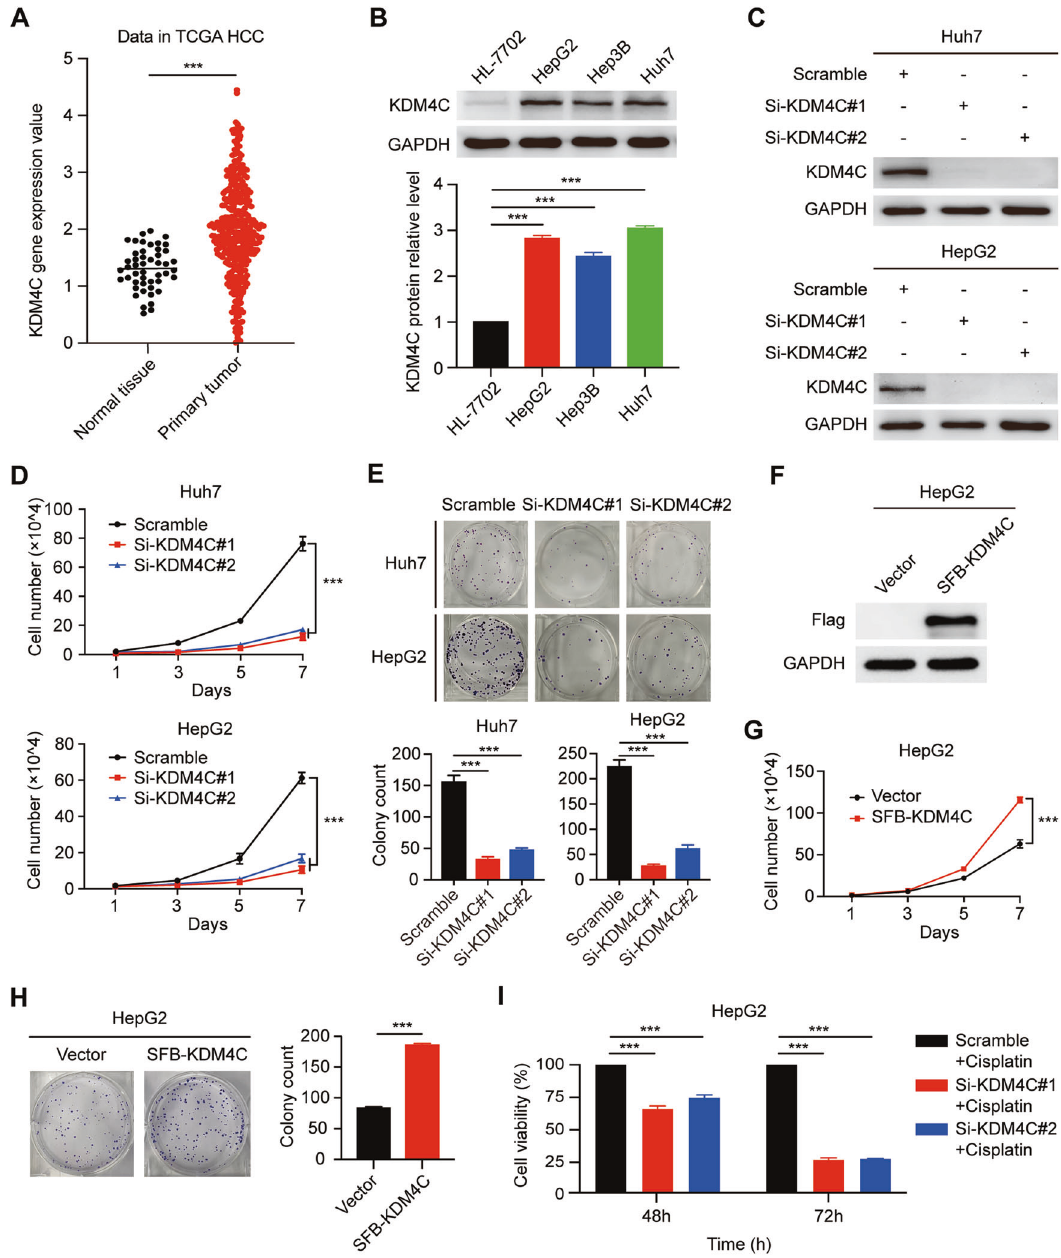
Fig. 1 KDM4C is upregulated in HCC and promotes cell growth and proliferation. A KDM4C was upregulated in primary HCC tumor tissue than in normal tissue in TCGA dataset. B Upper panel: the protein expression levels of KDM4C in several cell lines were measured by western blotting. Lower panel: the gray values of the protein bands were quanti fi ed using ImageJ software ( n = 3). C KDM4C was effectively knocked down in Huh7 and HepG2 cells using the two indicated siRNAs ( n = 3). D Cells were transfected with the indicated siRNAs, seeded in six-well plates and counted every other day ( n = 3). E Cells transfected with the indicated siRNAs were plated and cultured in six-well plates (500 cells/ well) for 2 weeks followed by fi xation and staining. Colony (>50 cells) numbers were counted ( n = 3). F HepG2 cells transfected with SFB- tagged KDM4C were lysed and analyzed by western blotting ( n = 3). G , H Overexpression of KDM4C promoted cell growth and proliferation in HepG2 cells ( n = 3). I HepG2 cells were transfected with the indicated siRNAs for 24 h and then treated with 0.6 μ M cisplatin. The percentage of cell viability was measured after 48 and 72 h ( n =